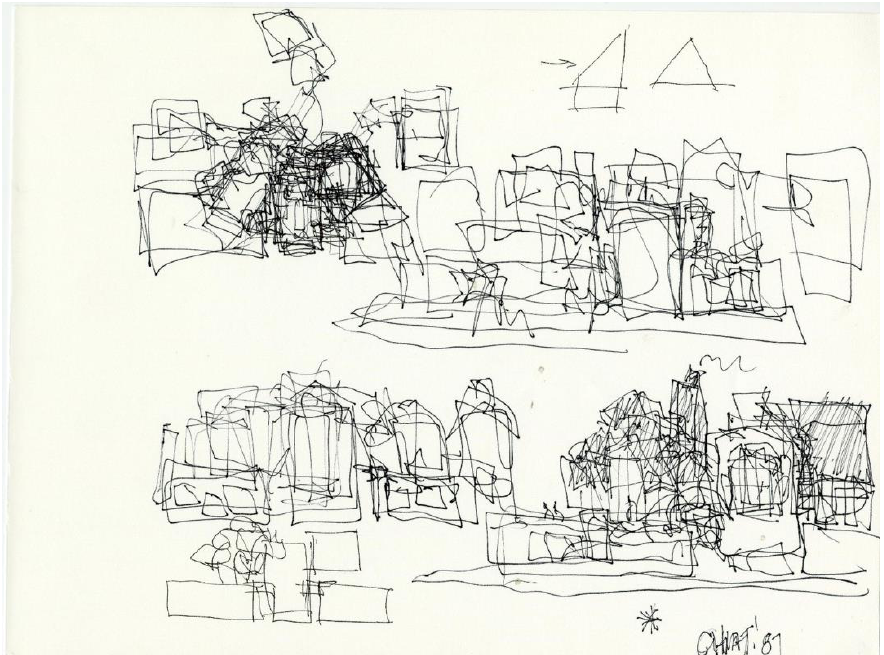
Figure 1. Frank Gehry, ‘drawdlings’ for the Jay Chiat Residence, Sagaponeck, New York, 1986 © Frank O. Gehry. Frank Gehry papers, Series I: Architectural Projects, Getty Research Institute, Los Angeles, CA. Digital image courtesy of the Getty Research Institute Digital Collections.